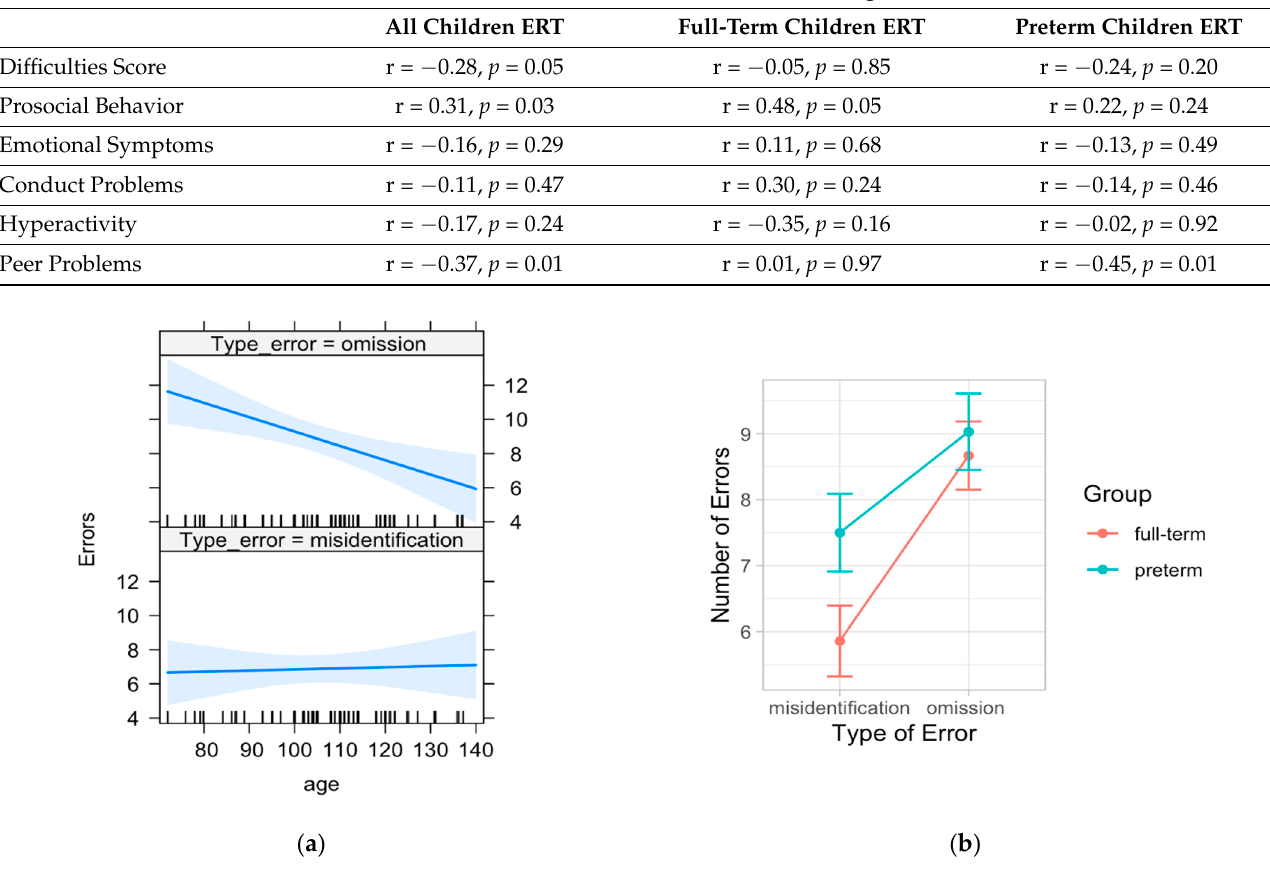
Figure 4. The left graph ( a ) shows of the interaction effect between age and type of error, while the right graph ( b ) shows the main effects of group and type of error.